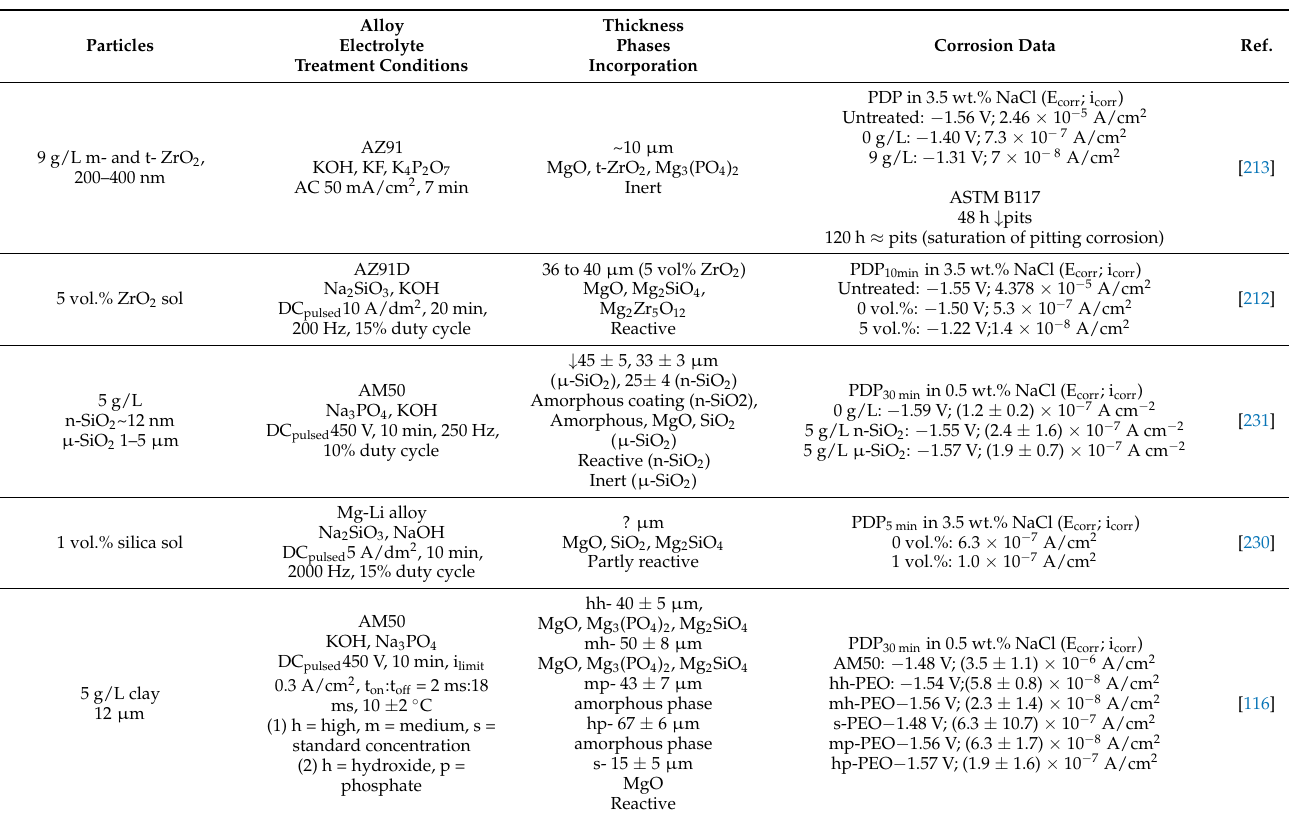
Table 5. Effect of in situ particle additives in PEO electrolytes on the structural and corrosive properties of the obtained